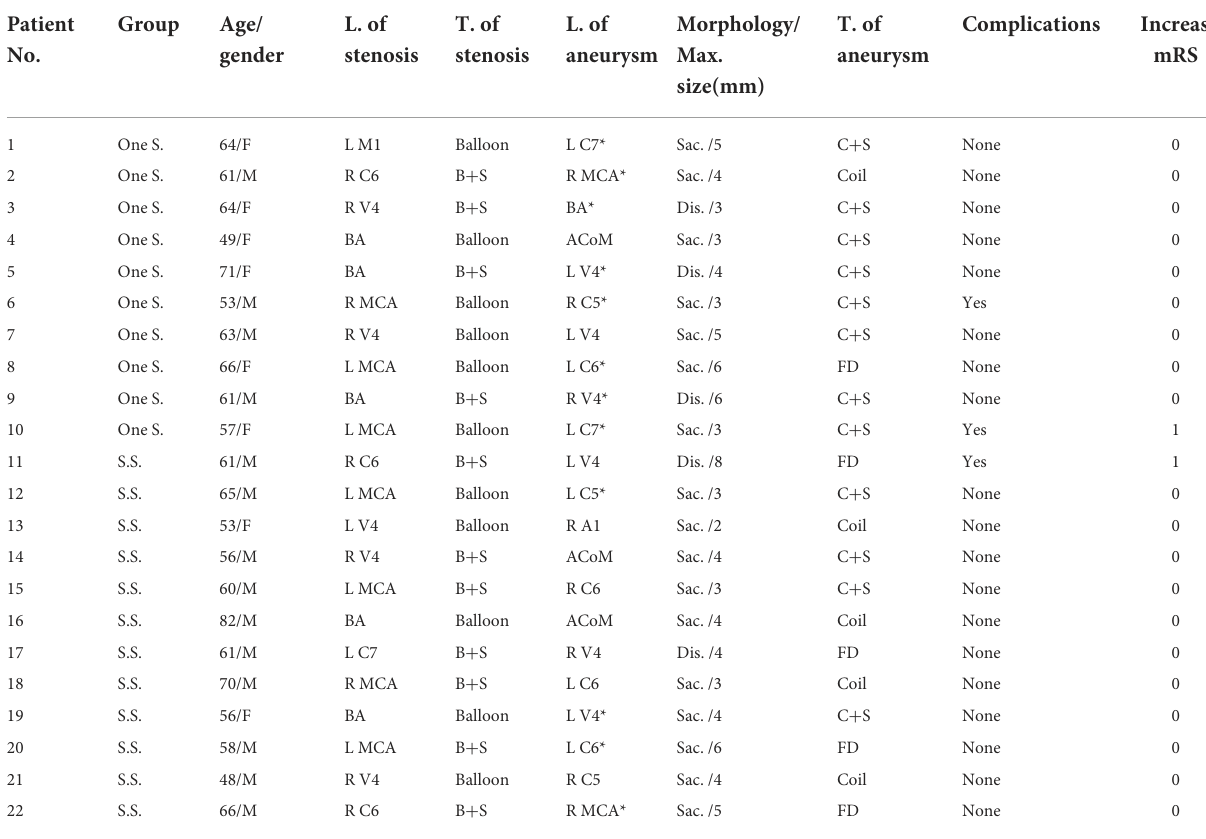
TABLE 1 Details of demographics, stenosis, and aneurysm of patients. Patient L. of